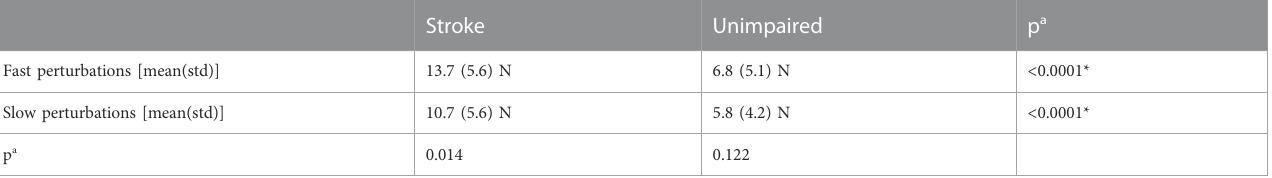
TABLE 2 Force peak ( F peak ) results considering all the fast or slow perturbations throughout the exercise in the stroke and unimpaired groups. Stroke p a Fast perturbations [mean(std)]